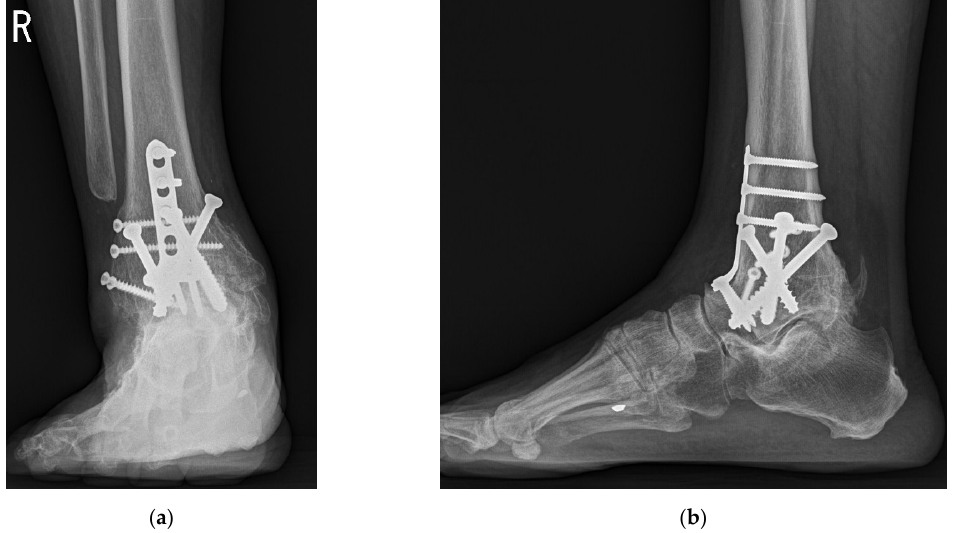
Figure 11. Postoperative weightbearing radiographs taken at 1 year after surgery showed union with improved position: ( a ) anteroposterior view; ( b ) lateral view.